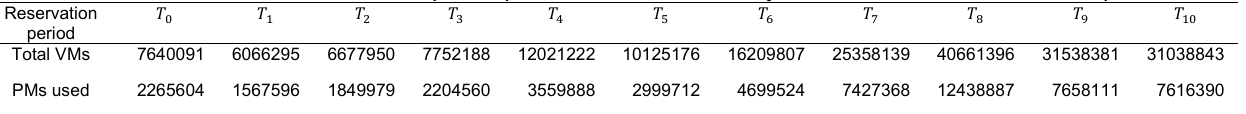
Table 4. Counts of total VM requests placed and PMs used by them at different reservation periods Reservation